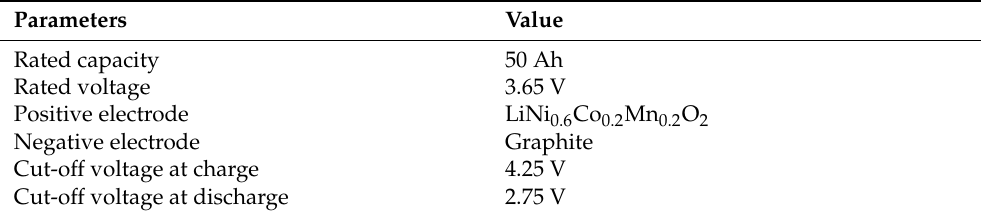
Figure 1. Prismatic lithium ‐ ion battery. ( a ) Front view; ( b ) temperature monitoring points [24]. Table 1. Basic parameters of the